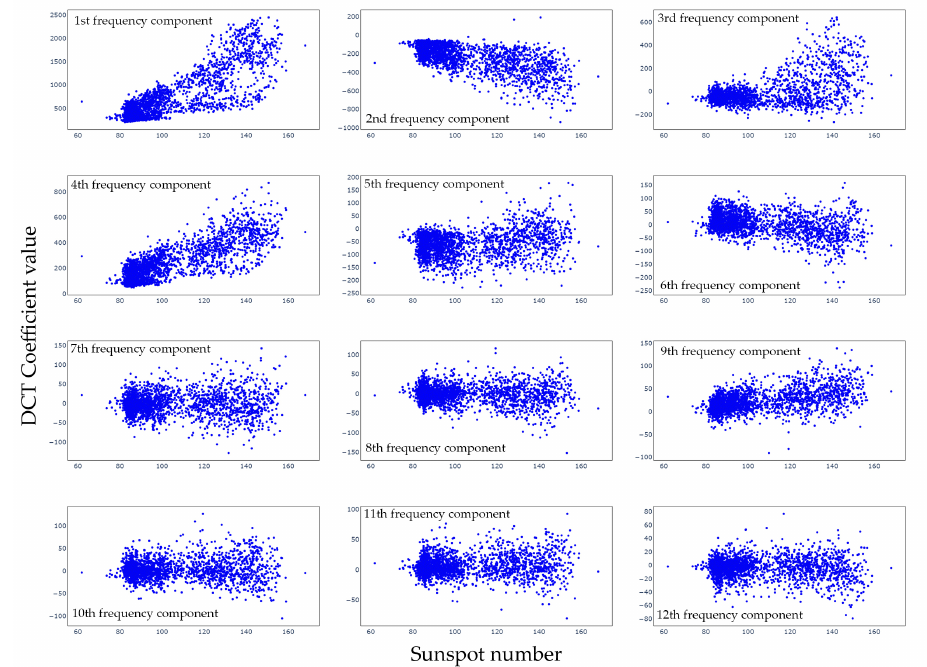
Figure 4. Amplitude of TEC frequency components versus sunspot number.